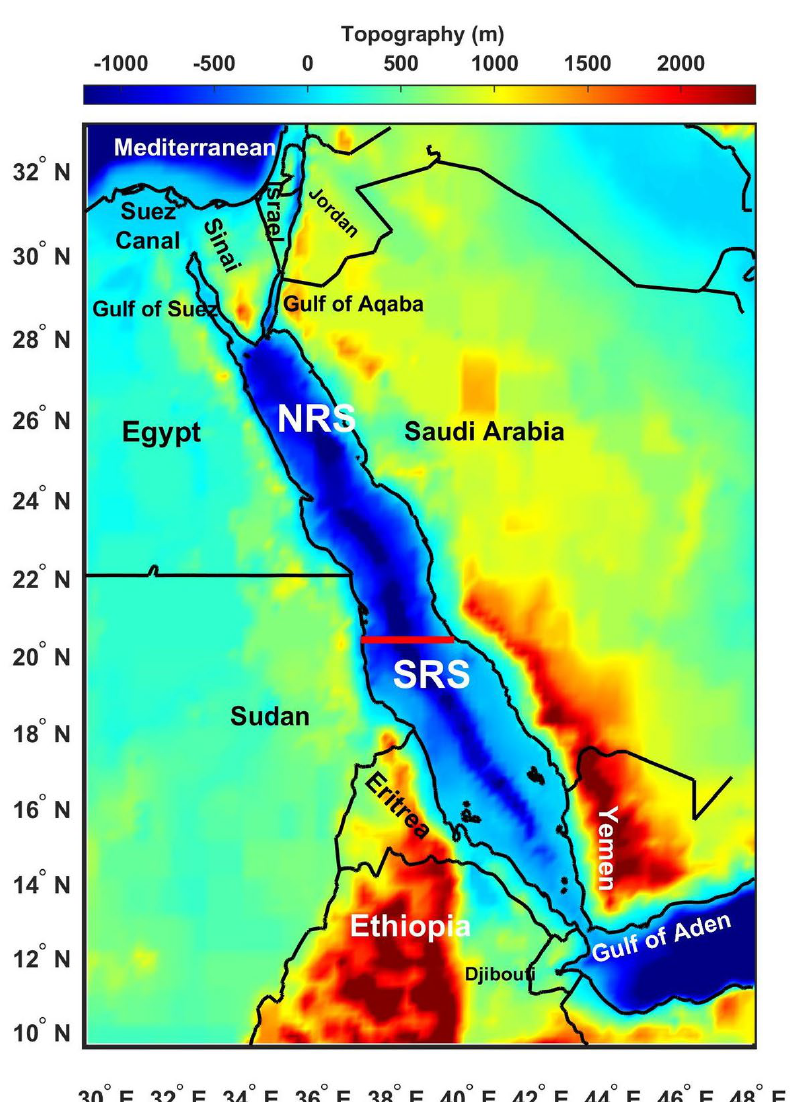
Figure 1. Red Sea topography with the main geographic features (e.g., countries) according to a 5 min (1/12 degree) global grid of topography from the World digital elevation model (ETOPO5) dataset, https://www.eea.europa.eu/data-and-maps/data/world-digital-elevation-model-etopo5 (accessed on 20 August 2021), where the solid red line at the 20° N geographical latitude separates the North Red Sea (NRS) and South Red Sea (SRS).